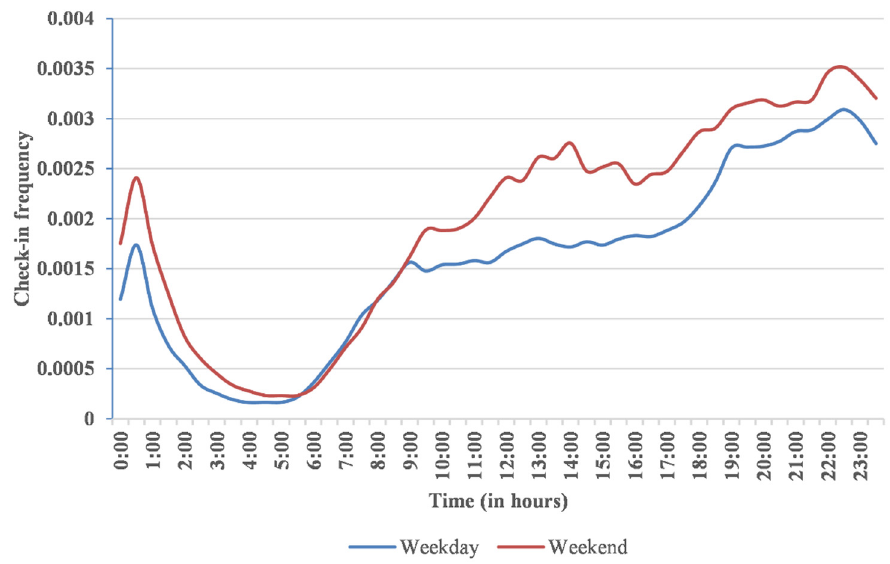
Figure 16. Check-in frequency of females during weekdays and the weekend. Figure 17 represents check-in density during the time intervals 00:00–08:59, 09:00–16:59, and 17:00–23:59. From Figure 17b,c, increasing check-in density can be observed during the time intervals 09:00– 16:00 and 17:00–23:59.